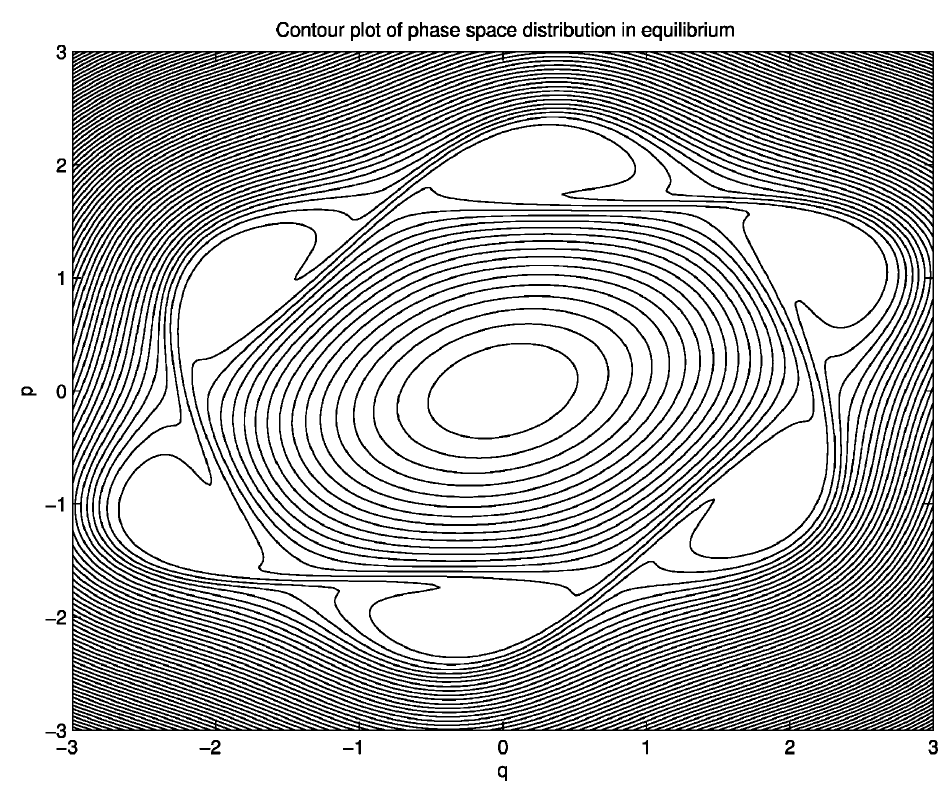
FIG. 5. Contour plot of f (cid:1) q; p (cid:2) in the equilibrium state.